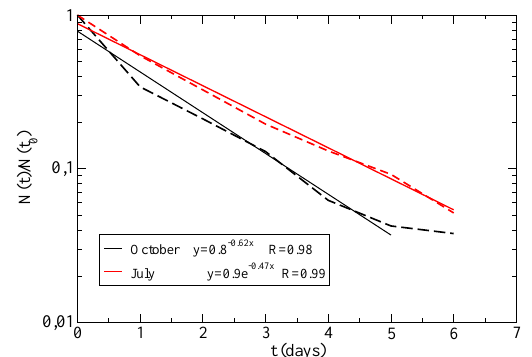
Fig. 6. Average of 15 subsequent (started at t 0 values separated 18h) estimations of N(t) , the number of particles remaining in the Bay of Palma at least for a lapse of time t after release at t 0 . Black and red lines are for surface layer in October and July respectively. Dashed lines are the measured averages, and the solid lines are the indicated exponential